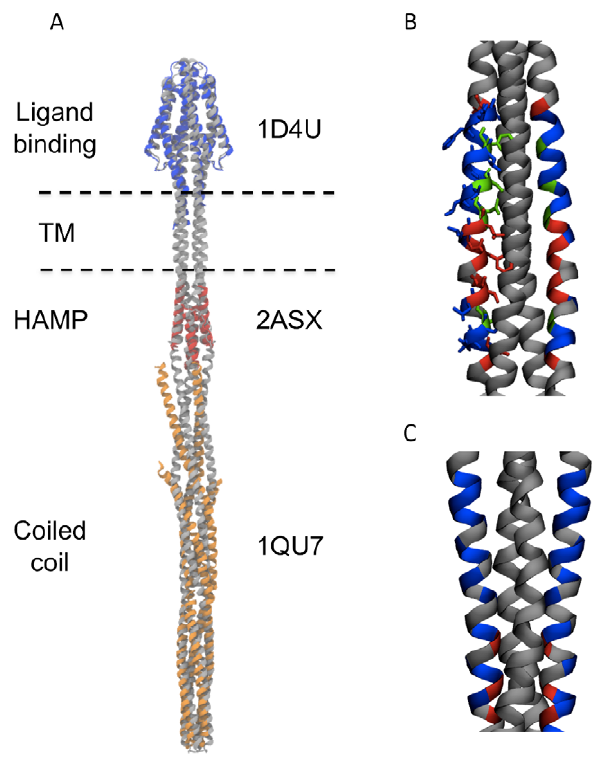
Figure 2. Initial model of Tsr dimer. A Initial symmetric dimer in grey, overlaid onto the aligned crystal structures (ligand binding domain in blue, HAMP domain in red, and coiled coil region in orange). AS2 helices are positioned on the left and right of the HAMP domain. (B) and (C) Disulphide mapping data, plotted as colours on the surface of the TM domain for B TM1 and C TM2. Red residues crosslink strongly, green residues crosslink to an intermediate extent, and blue residues do not crosslink. In both diagrams it can be seen that higher crosslinking efficiency residues face their dimeric partner, largely in agreement with experimental data (TM2 appears to match experimental data better than TM1).